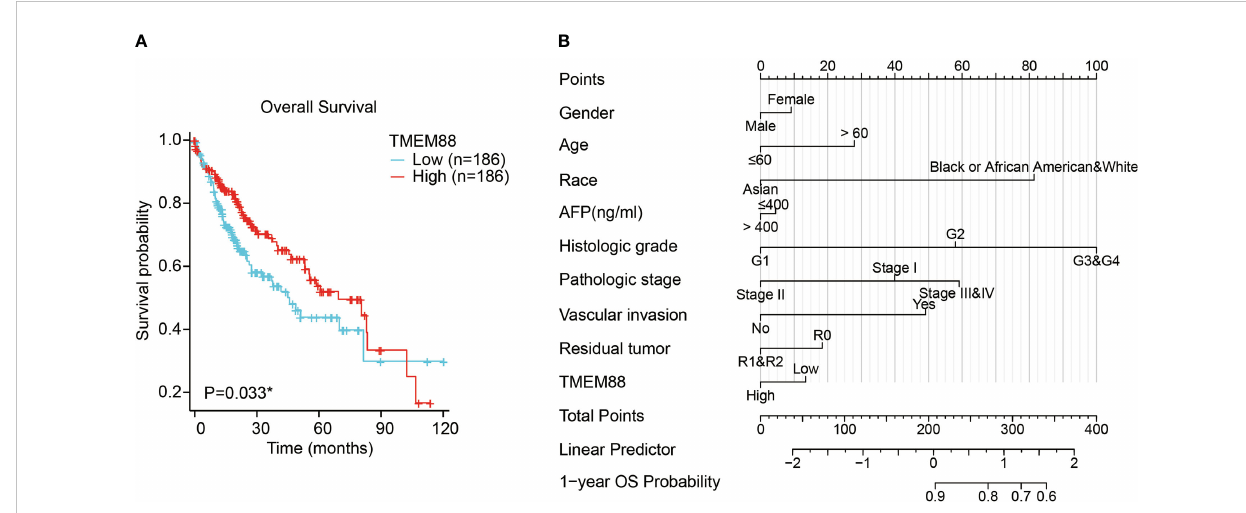
FIGURE 4 Lower TMEM88 predicted worse overall survival of HCC. (A) Kaplan-Meier survival analysis and log-rank test showed that HCC patients with lower TMEM88 mRNA level exhibited worse overall survival. (B) A prognostic predicting nomogram was established according to the multivariate analysis data to help predict 1-year overall survival probability of HCC patients